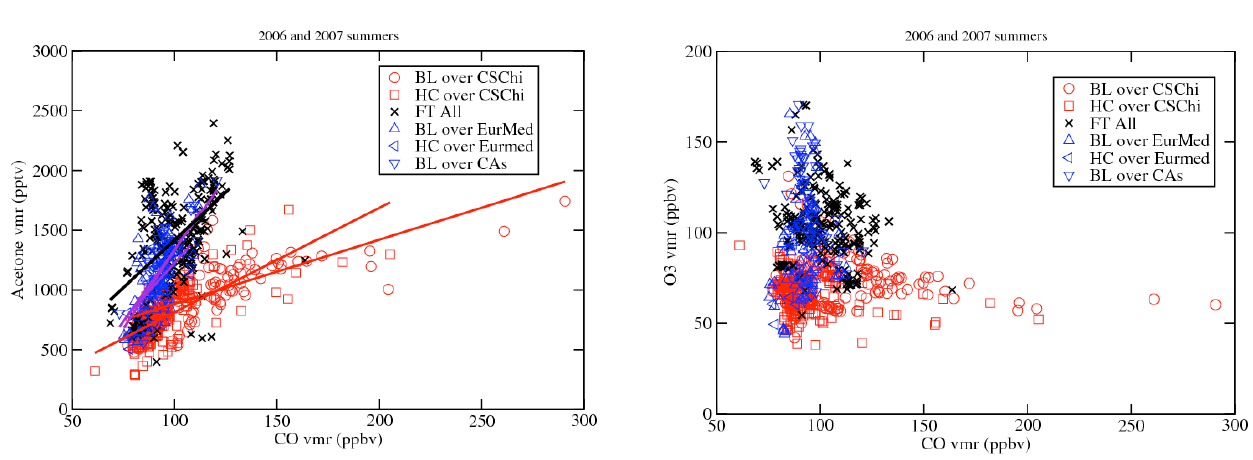
Figure 10. Acetone/CO signature in various air masses sampled in 2006 and 2007 summers. Linear regressions are plotted in red for HC and BL air masses sampled over CSChi, in purple